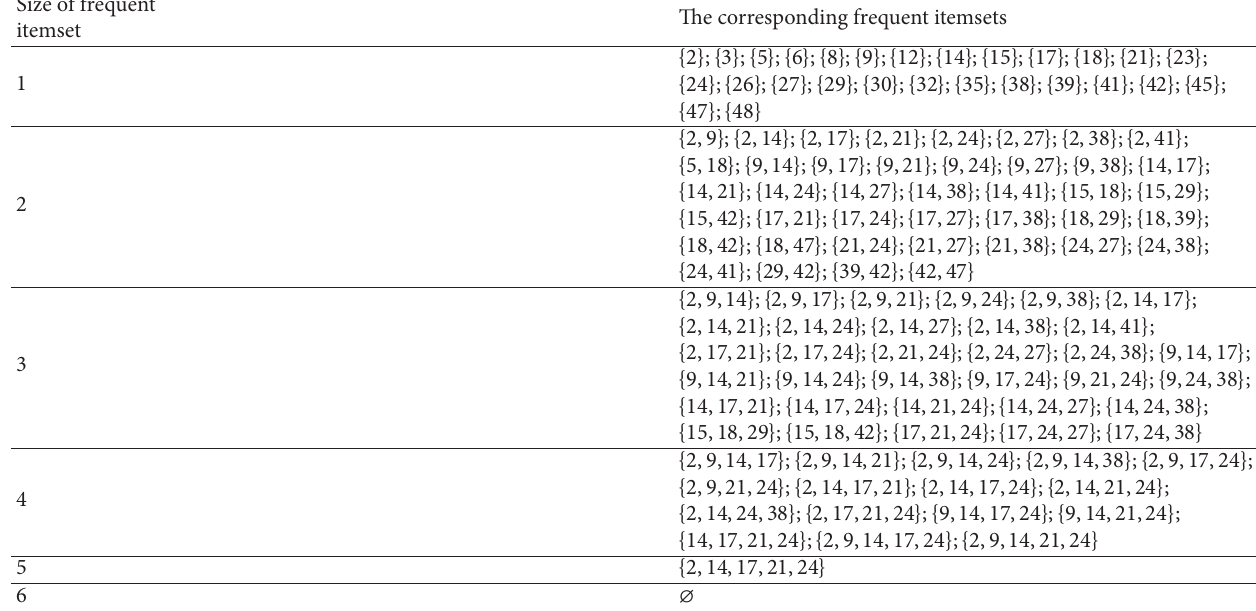
Table 7: The frequent itemsets identified by ECTPPI-Apriori for the Congressional Voting Records